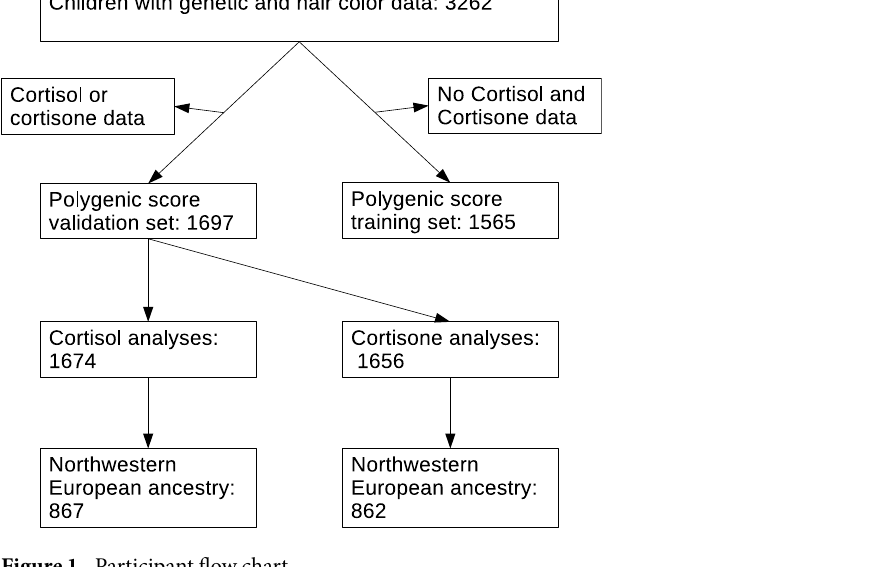
Figure 1. Participant flow